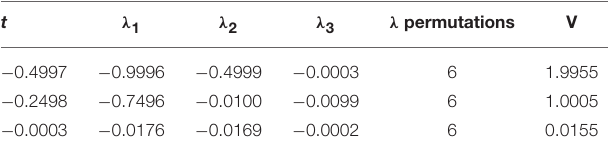
TABLE 3 | Numerical solutions for N = 3 at g =